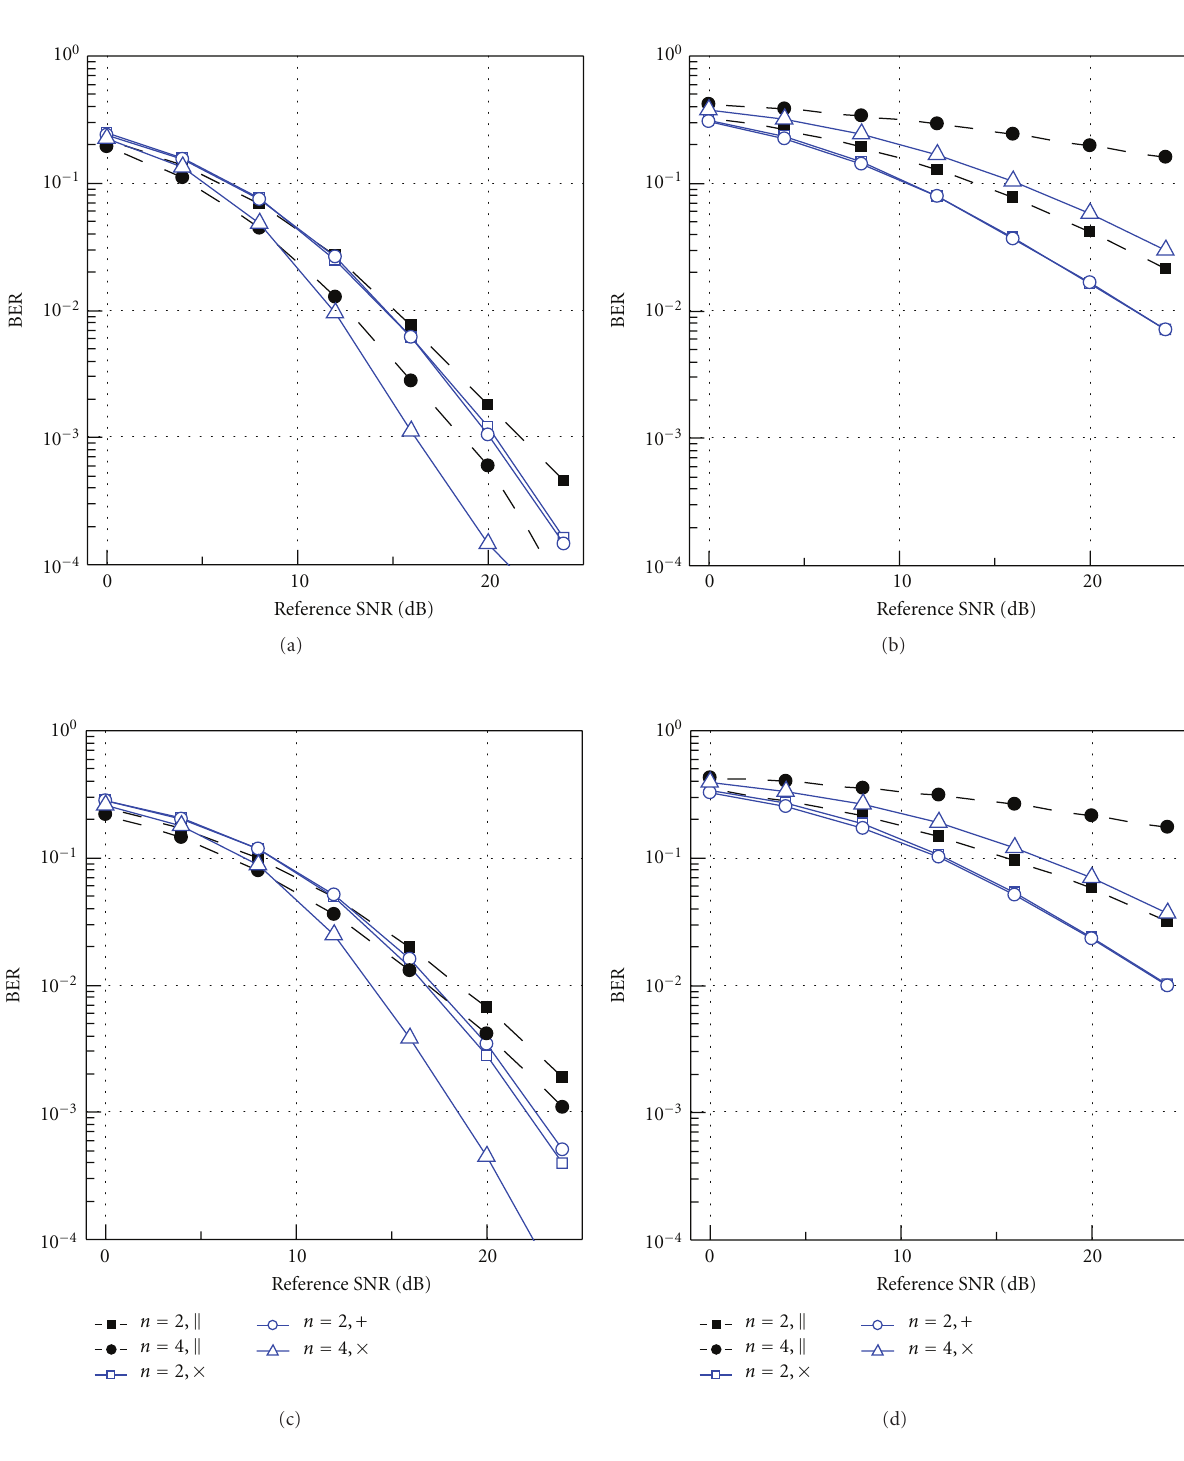
Figure 8: Impact of orientation randomness on BER performances of the SM MIMO systems with matching networks when: (a) XPD = 0dB, ML receiver; (b) XPD = 0dB, ZF receiver; (c) XPD = − 6dB, ML receiver; (d) XPD = − 6 dB, ZF